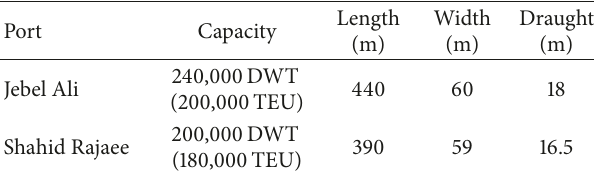
Table 4: Technical specifications of the largest container ship (design vessel) that entered port of Jebel Ali and Shahid Rajaee port.